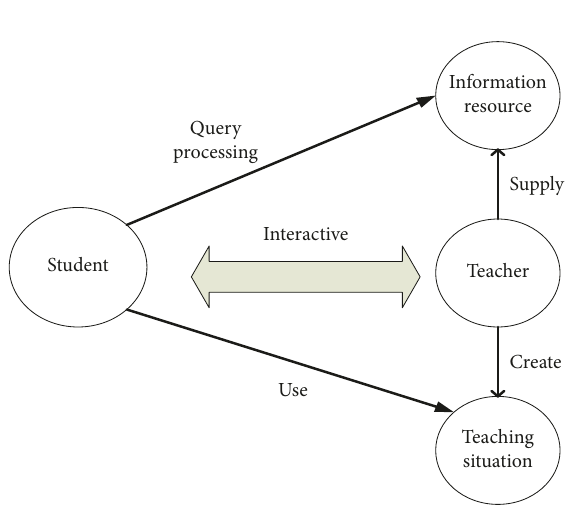
Figure 3: Data mining process of machine learning in smart learning.